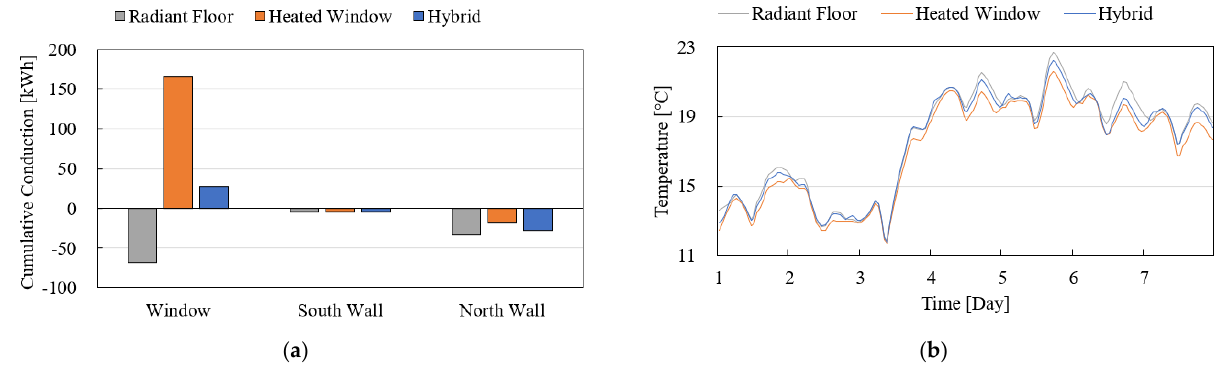
Figure 8. Inner surface conduction and difference in air temperature between room and common zones. ( a ) Cumulative conduction on inner surfaces of window, south wall (glass zone), and north wall (room zone) for each heating system at night (00:00–04:00); ( b ) Difference in air temperature between room zone and common zone for each heating system for one week (1-7 December).